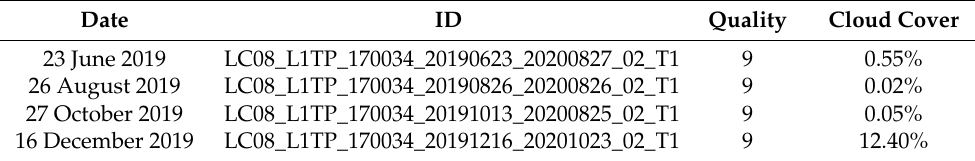
Table 1. Landsat OLI raw